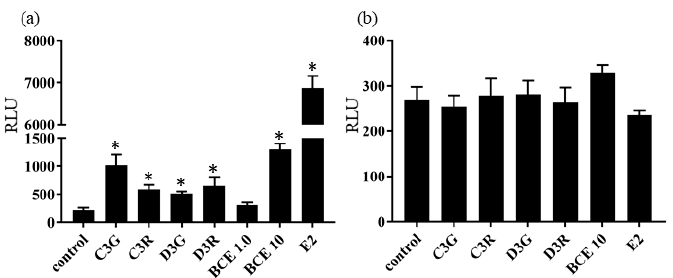
Figure 2. ER β reporter assay of cells treated with 50 μ M anthocyanins and 1.0 or 10.0 μ g/mL blackcurrant extracts (BCE) or 100 pM 17 β -estradiol (E2) in the absence ( a ) or presence ( b ) of 1.0 μ M fulvestrant for 24 h. RLU, relative light units. Data are shown as the mean ± standard error of the mean of at least three independent experiments. * p < 0.05 vs. control.